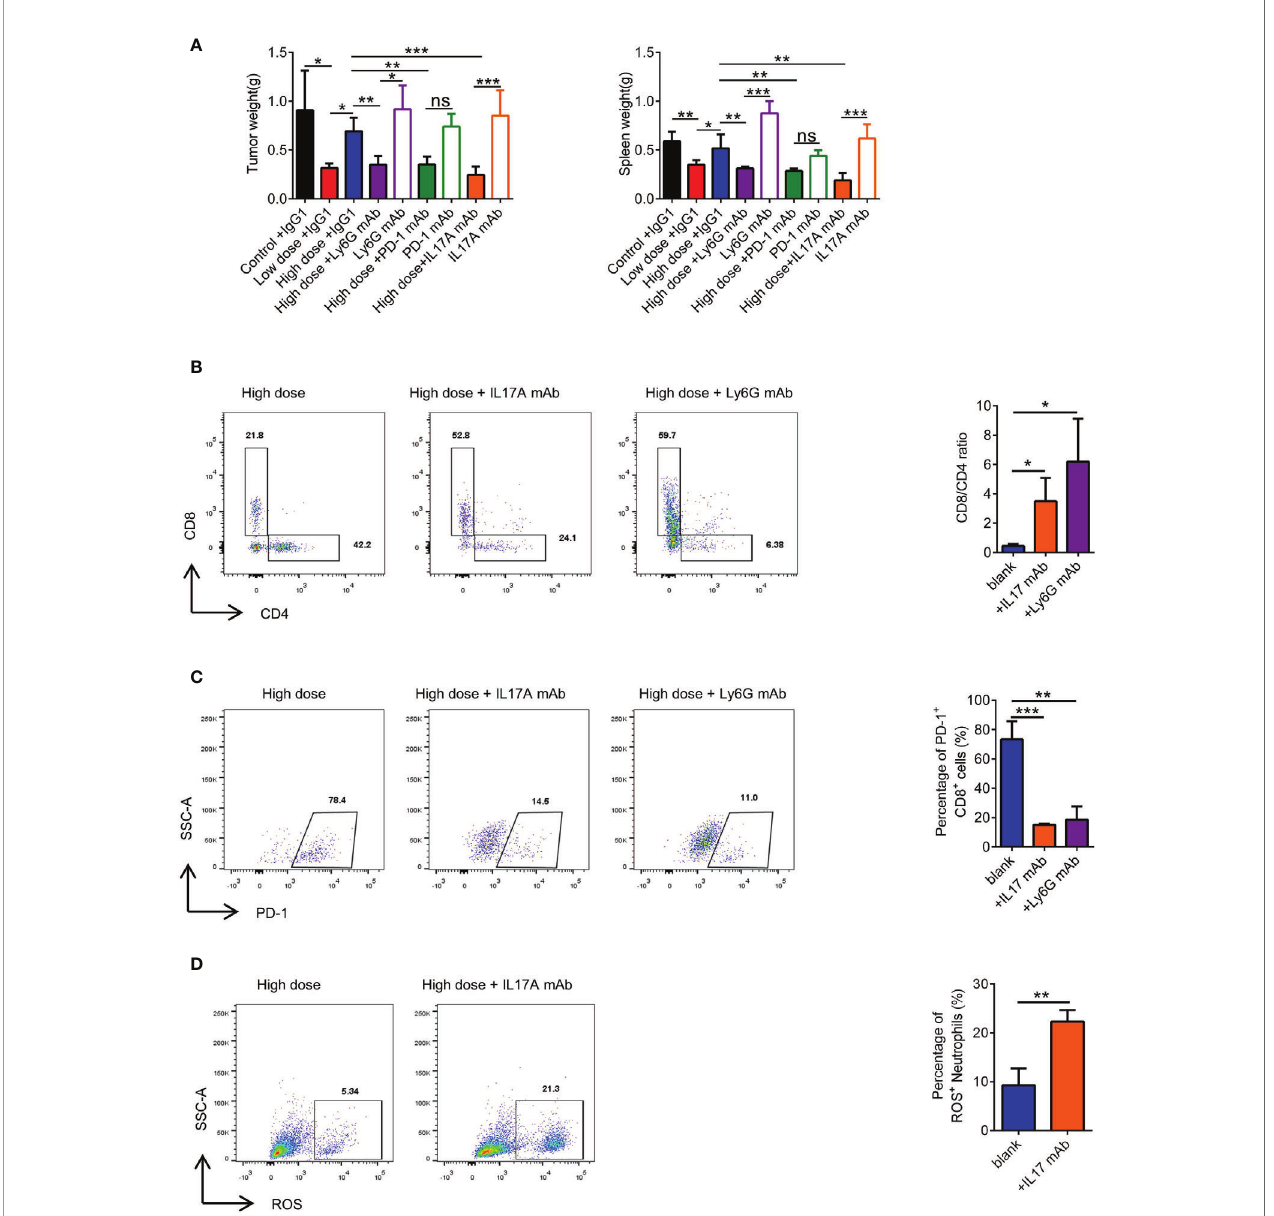
FIGURE 7 | Combination with immunotherapeutic monoclonal antibody can rescue high-dose VEGFR2-TKI therapy. (A) Representative weight of primary tumor and spleen after high-dose VEGFR2-TKI therapy and(or) IL17A mAb, PD-1 mAb or Ly6G mAb. (B) Frequency of CD4 + T cells and CD8 + T cells in the tumor after high- dose VEGFR2-TKI therapy and(or) IL17A mAb or Ly6G mAb. (C) Frequency of PD-1 expression on CD8 + T cells in the tumor after high-dose VEGFR2-TKI therapy and(or) IL17A mAb or Ly6G mAb. (D) The expression of ROS in neutrophils after high-dose VEGFR2-TKI therapy and (or) IL17A mAb. Data are presented as the means ± SD from one representative experiment. Similar results were obtained from three independent experiments, n=5 mice each group, unless indicated otherwise. Statistical analysis was performed by two-tailed unpaired Student ’ s t test (D) and one-way ANOVA (A – C) . ns, not signi fi cant, *p < 0.05, **p < 0.01, and ***p < 0.001. See also Supplementary Figure S7